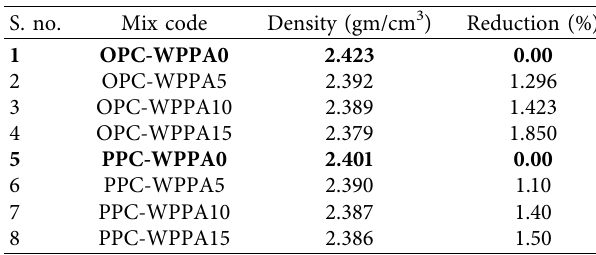
Table 12: Density of OPC-WPPA and PPC-WPPA